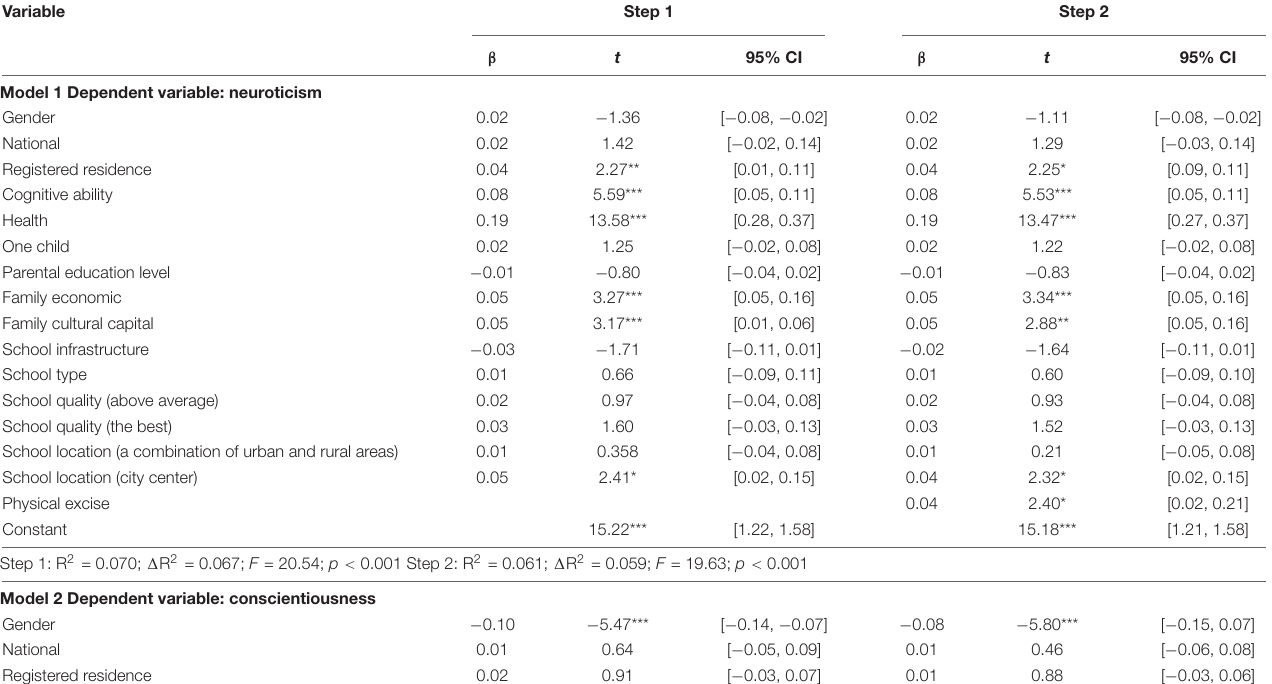
TABLE 3 | Regression results of physical exercise and adolescent personality development ( N = 9,284). Variable Step 1 Step 2